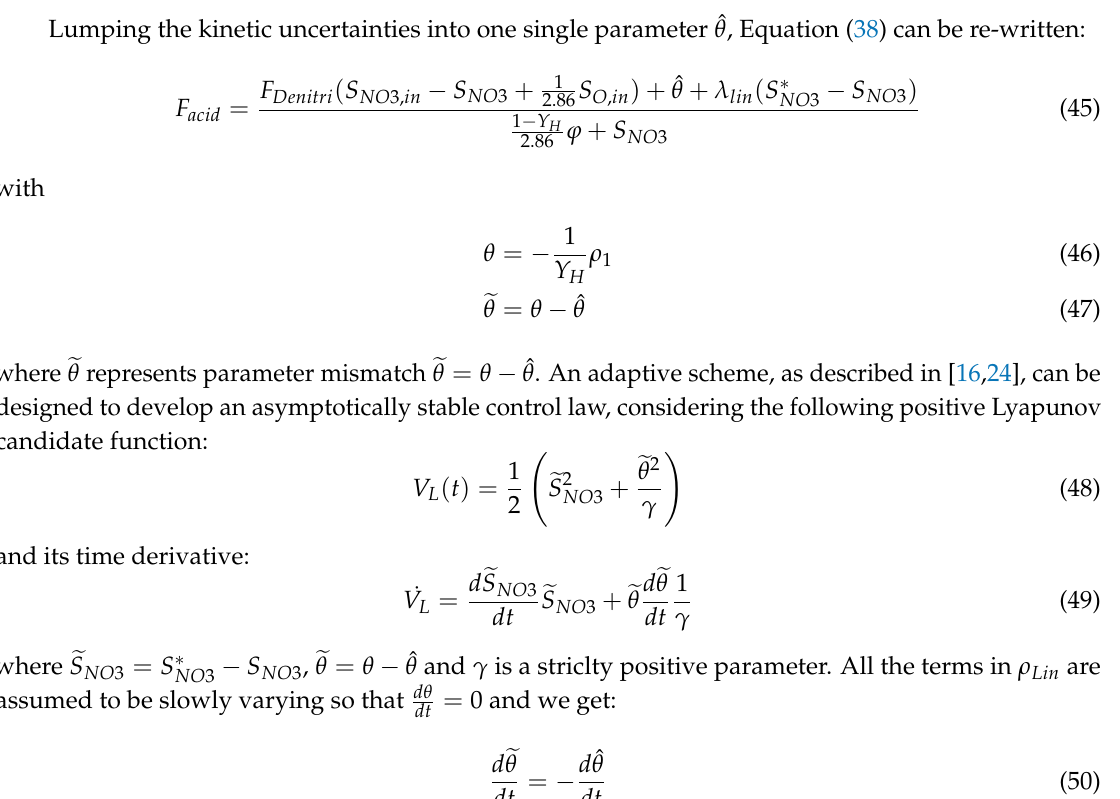
Figure 13. Linearizing controller and PI in Figure 12. Linearizing controller and PI in cascade.